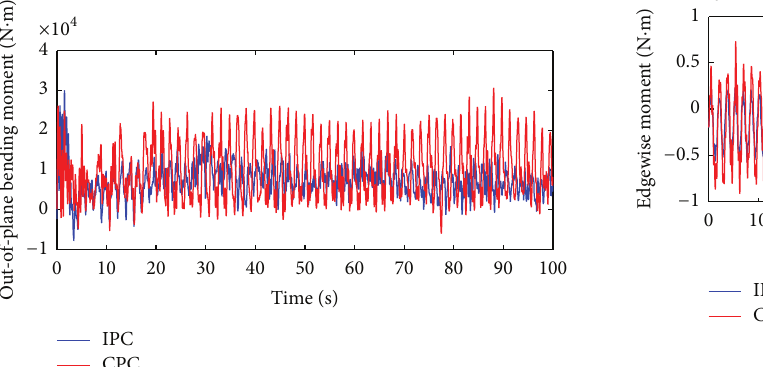
Figure 12: Edgewise moment.